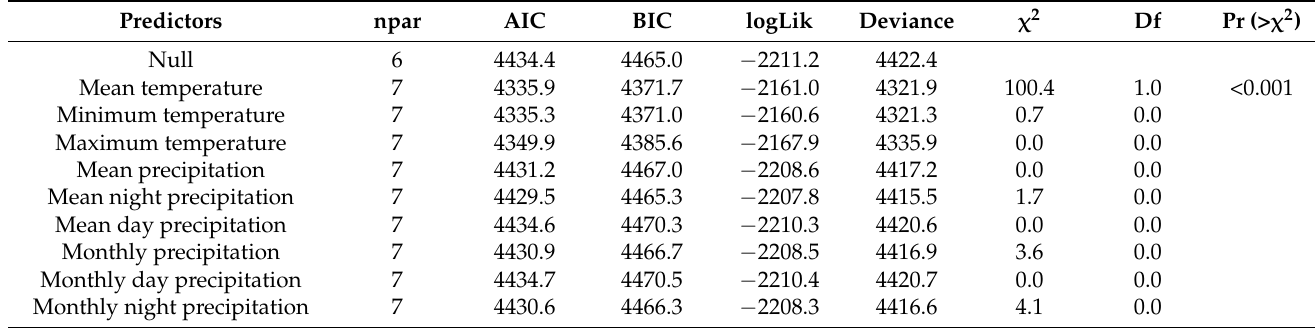
Table 2. The models with a single predictor compared with the null